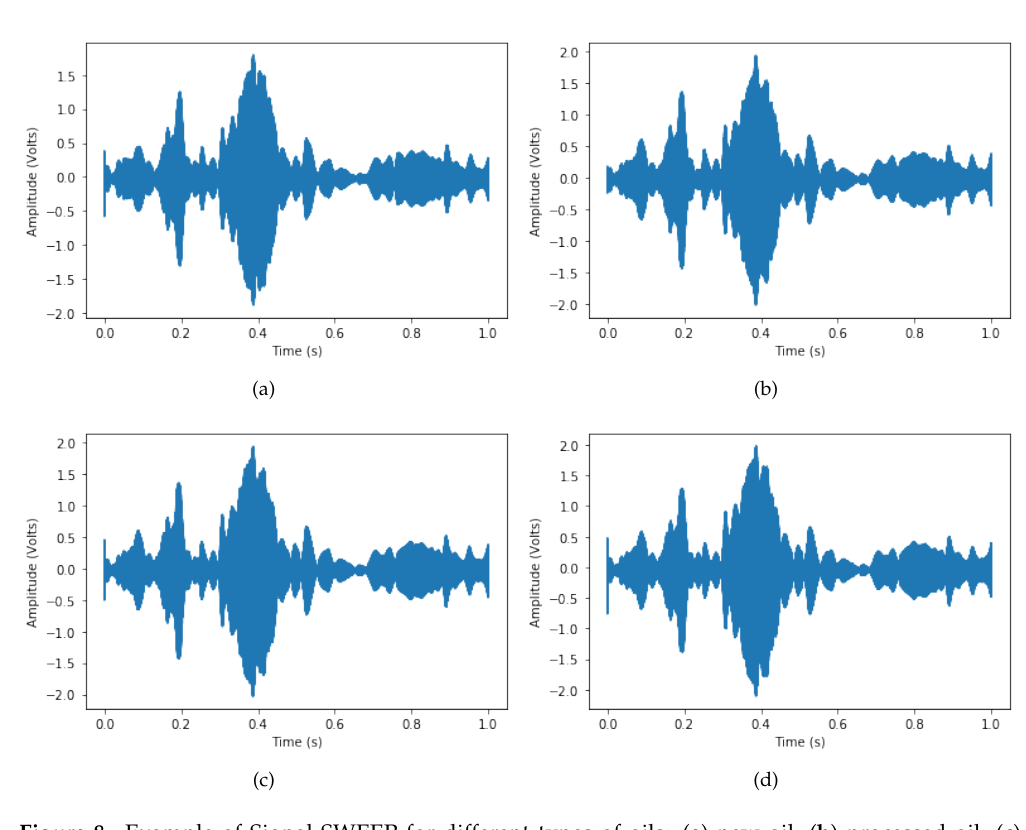
Figure 8. Example of Signal SWEEP for different types of oils: ( a ) new oil; ( b ) processed oil; ( c ) contaminated oil; and ( d ) out of service oil (Database